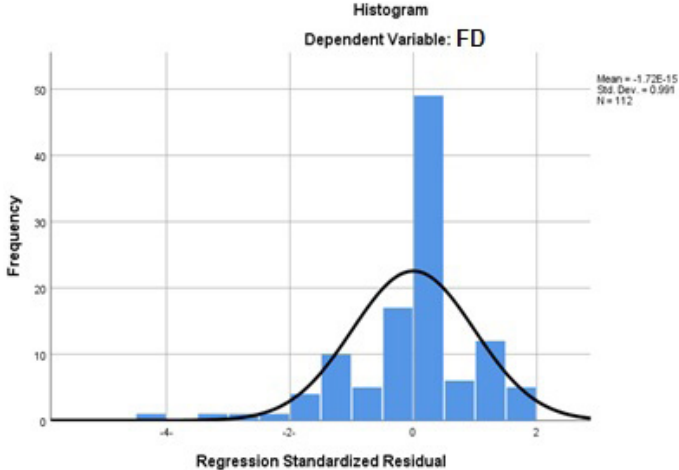
Figure 2. Regression standardized